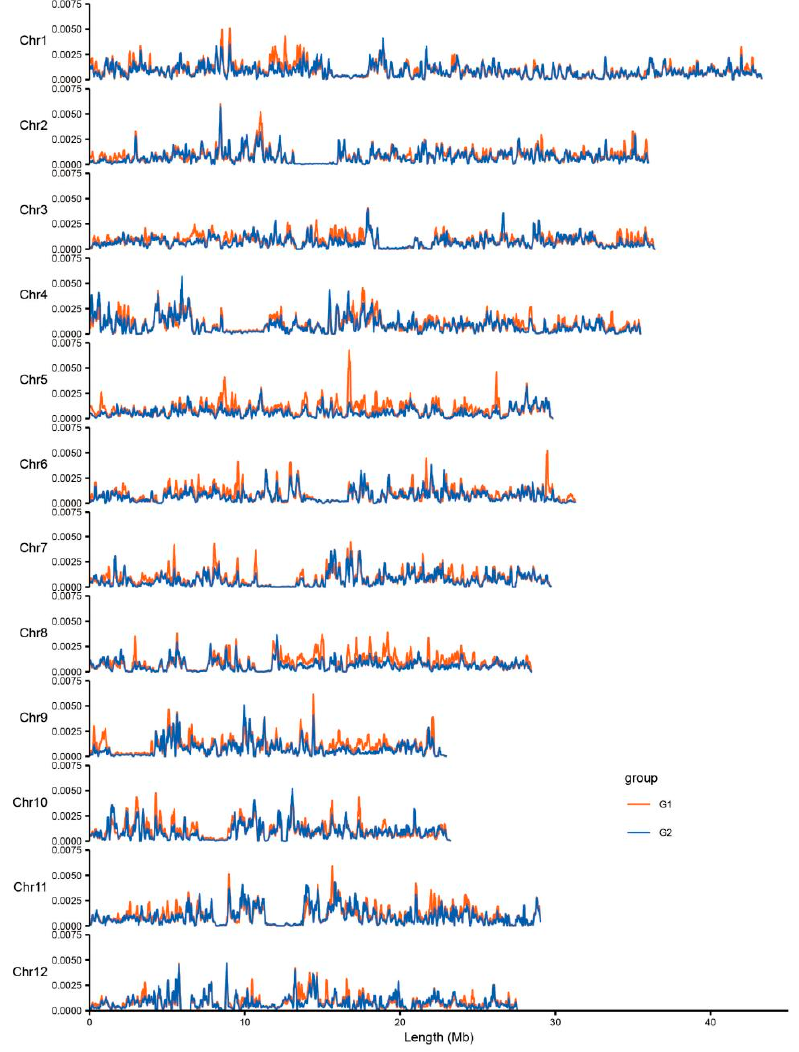
Figure 8. Π values for the 100 kb sliding window with a 10 kb step size across the rice genome for two DXWR subpopulations. G1: G1 subpopulations of DXWR; G2: G2 subpopulations of DXWR.